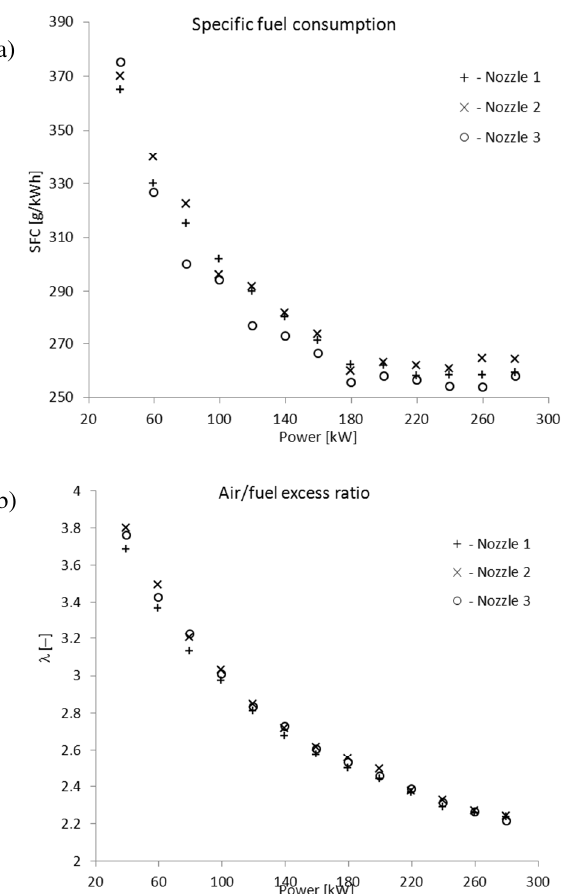
Fig. 3. Specific fuel consumption and the air/fuel excess